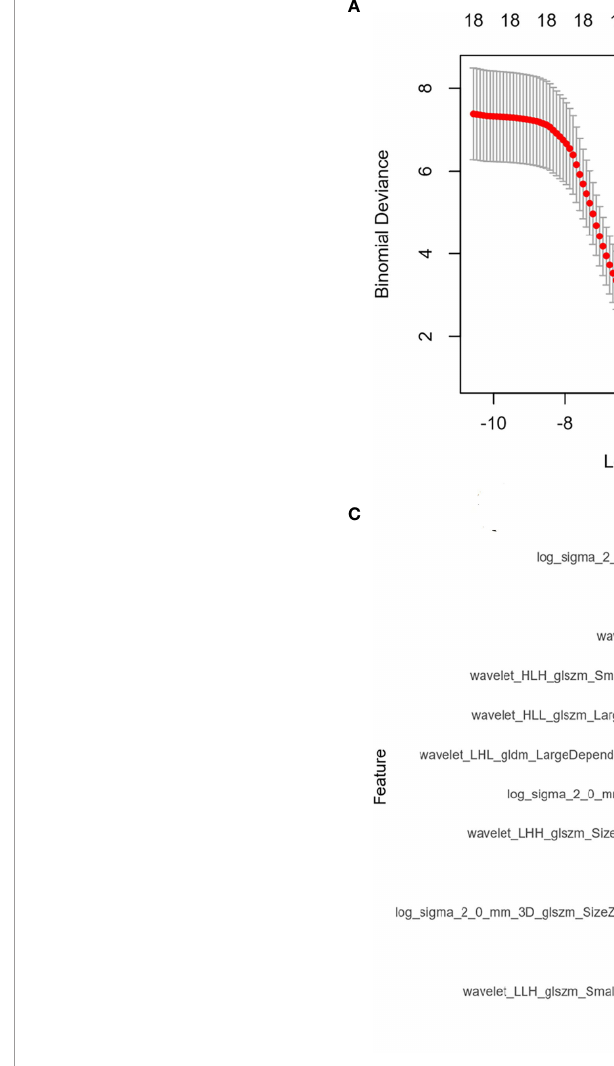
FIGURE 4 | Feature extraction of Delta radiomics. (A) Uses ten-fold cross-validation and minimum criteria to select the adjustment parameter ( l ). (B) LASSO coef fi cients of 20 texture features, drawing vertical lines at the selected optimal value in l sequence. (C) Screens twelve features. LASSO, least absolute shrinkage and selection